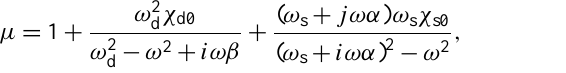
Figure 5. Equivalent input referred noise (in nV sured using a 50 (cid:127) input